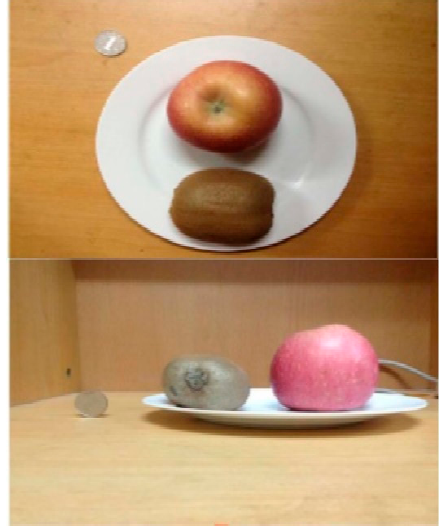
Figure 2. Measuring relative volumes by pixel density, Liang and Li. 2019 .